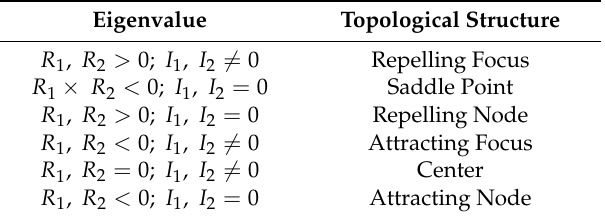
Table 1. The corresponding relationship between eigenvalue and topological